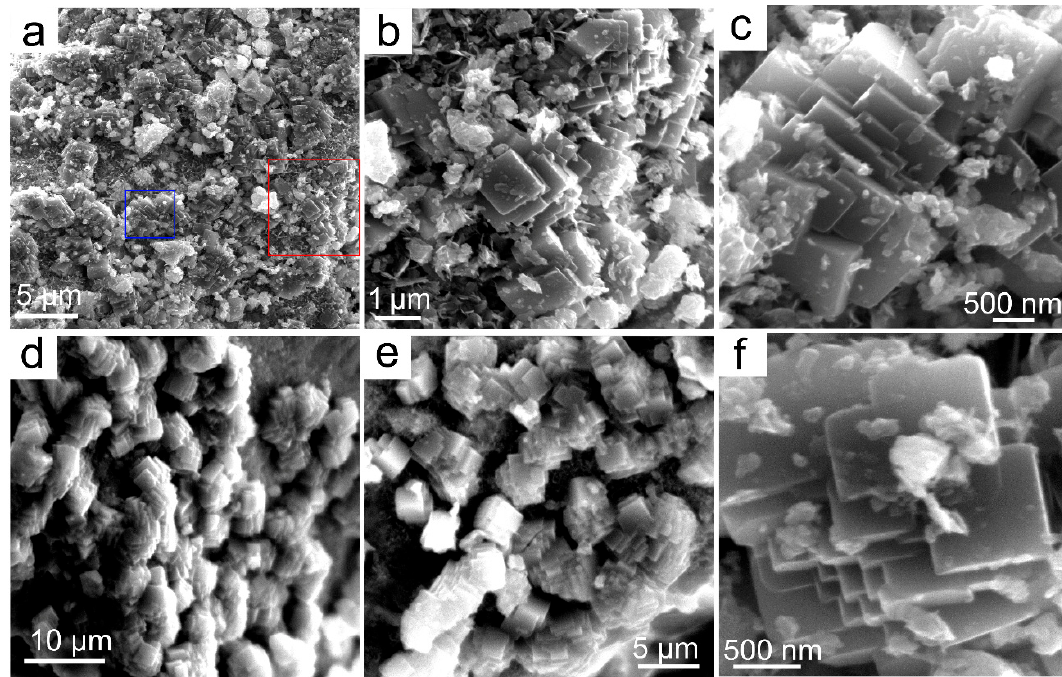
Figure 7. SEM micrograph of ( a ) analcime crystals synthesized in run Et5; ( b ) magnification of the area delimited by the red square in (a); ( c ) magnification of the area delimited by the blue square in micrograph (a); ( d – f ) analcime crystals synthesized in run Et6.